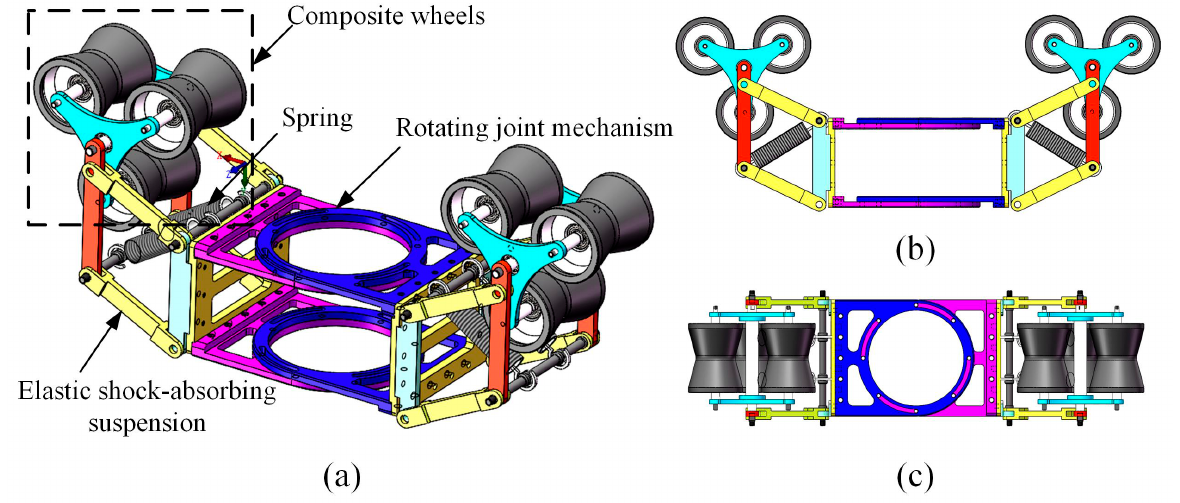
Figure 4. Composite wheels and elastic shock-absorbing suspension mechanisms: ( a ) Overall view; ( b ) Side view; ( c ) Top view.